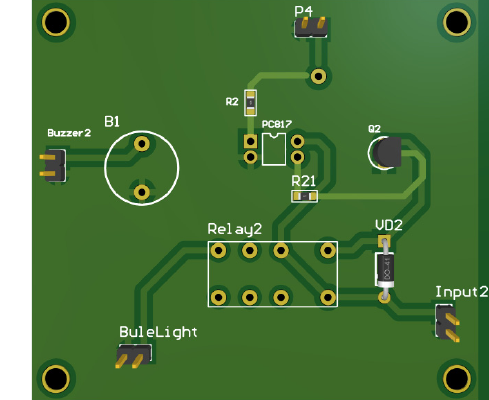
Figure 23. GPS data upload format. The transmission format of the independent key locker transmits data every second in the JSON format to find out whether a registered user in the server uses a vehicle. This action is verified through the computer’s serial transmission platform SSCOM. When ac- cessing the background database system, it returns messages such as “myregion” (the company’s area), “myboxID” (the cabinet), “has_open” (whether there is an open cabinet), and “box_status” (whether the cabinet has the key and STB). If no user uses the key and STB in a sub-cabinet, the return values of the “has_open” and “box_status” background database systems are both “0”, as shown in Figure 24.